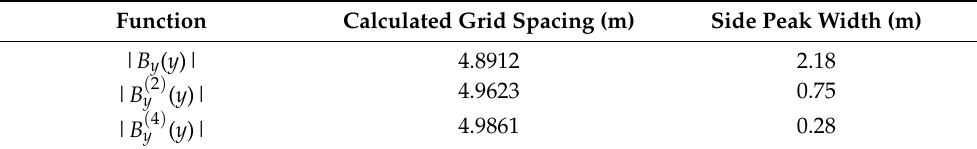
Table 2. Simulation results of grid size.